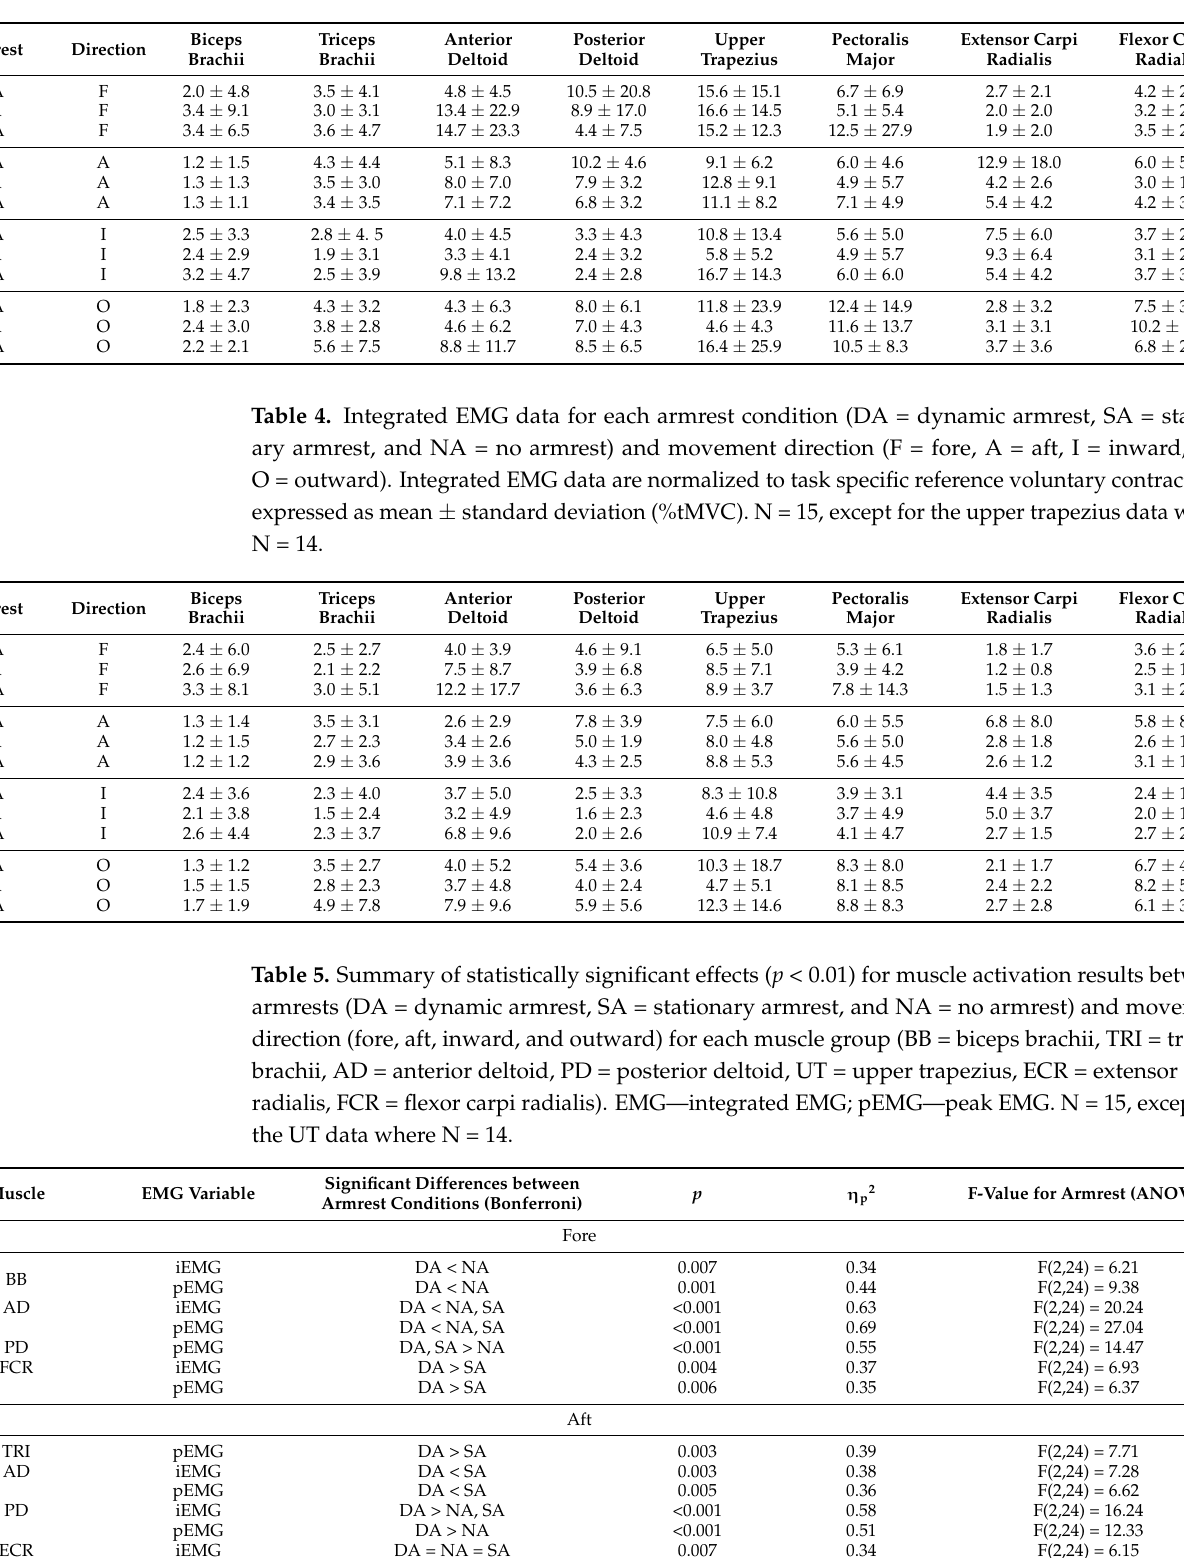
Table 3. Peak EMG data for each armrest condition (DA = dynamic armrest, SA = stationary armrest, and NA = no armrest) and movement direction (F = fore, A = aft, I = inward, and O = outward). Peak EMG data are normalized to task specific reference voluntary contractions, expressed as the mean ± standard deviation (%tMVC). N = 15, except for the upper trapezius data where N = 14.